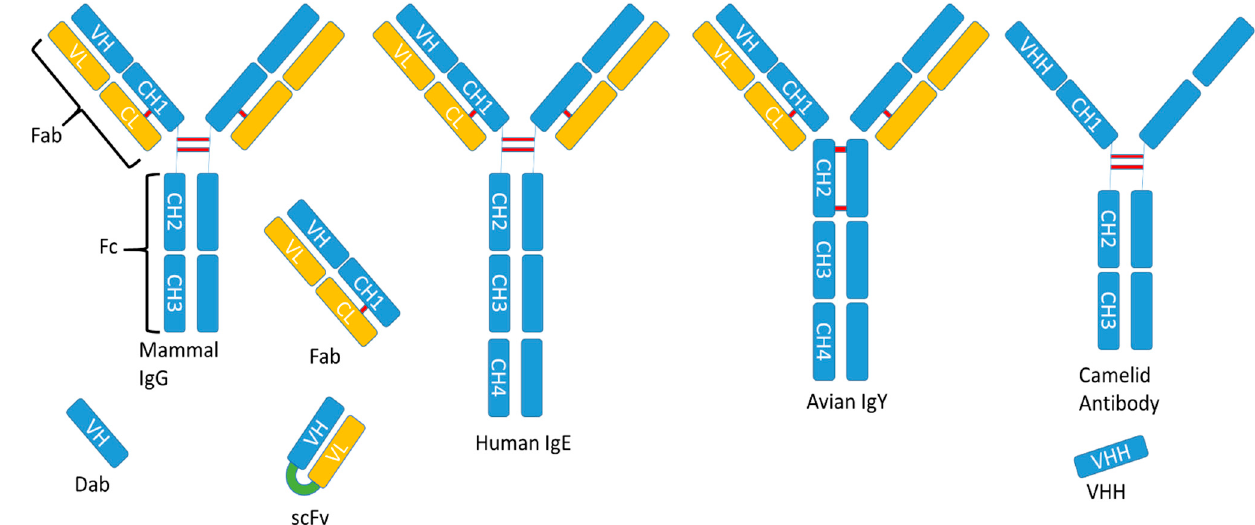
Figure 1. Schematic representation of the structure of antibodies and derived molecules: Ig (Immunoglobulins); Fab (Frag- ment for antigen binding); Fc (Fragment crystallizable); VH (Variable region of Heavy chain); VL (Variable region of Light chain); CH (Constant regions of Heavy chain); CL (Constant region of Light chain); Dab (single Domain antibody); ScFV (Single chain Fragment Variable); VHH (Variable domain of Heavy chain of Heavy chain antibody).